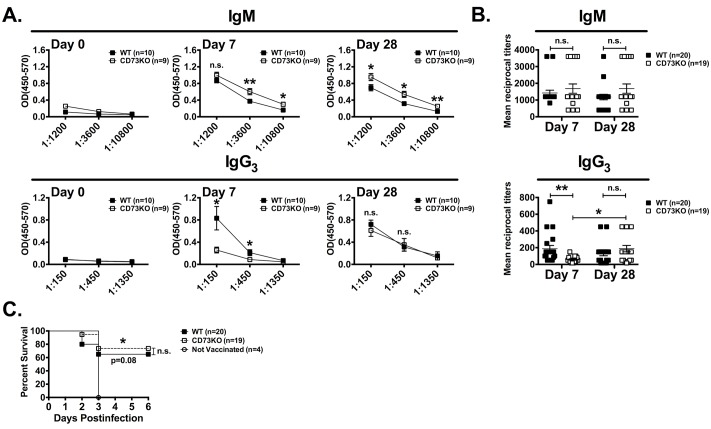
CD73-deficiency is associated with delayed IgG3 response after Pneumovax 23 vaccination.8 to 12-week-old WT and CD73 KO mice were immunized i.p. with Pneumovax 23 and sera were analyzed by ELISA for anti-PPS3 specific Abs at day 0, 7 and 28 after vaccination. On day 28, mice were challenged by i.p. injection of S. pneumoniae (105 CFU). (A) Anti-PPS3 IgM and IgG3 OD (450–570) readings are shown (means ± standard errors are shown; *: p<0.05; **: p<0.01 by Student’s T test). (B) Combined results from 2 experiments pooling 20 WT and 19 CD73 KO mice showing IgM and IgG3 mean reciprocal titers at day 7 and 28 (means ± standard errors are shown; **: p<0.01; by One-way ANOVA; brackets are shown when significantly different from day 7 and 28 for a given group). (C) Survival of infected mice was monitored (*: p<0.05 by log-rank test; survival was compared to non-vaccinated mice, unless indicated by brackets; n.s: not significant).